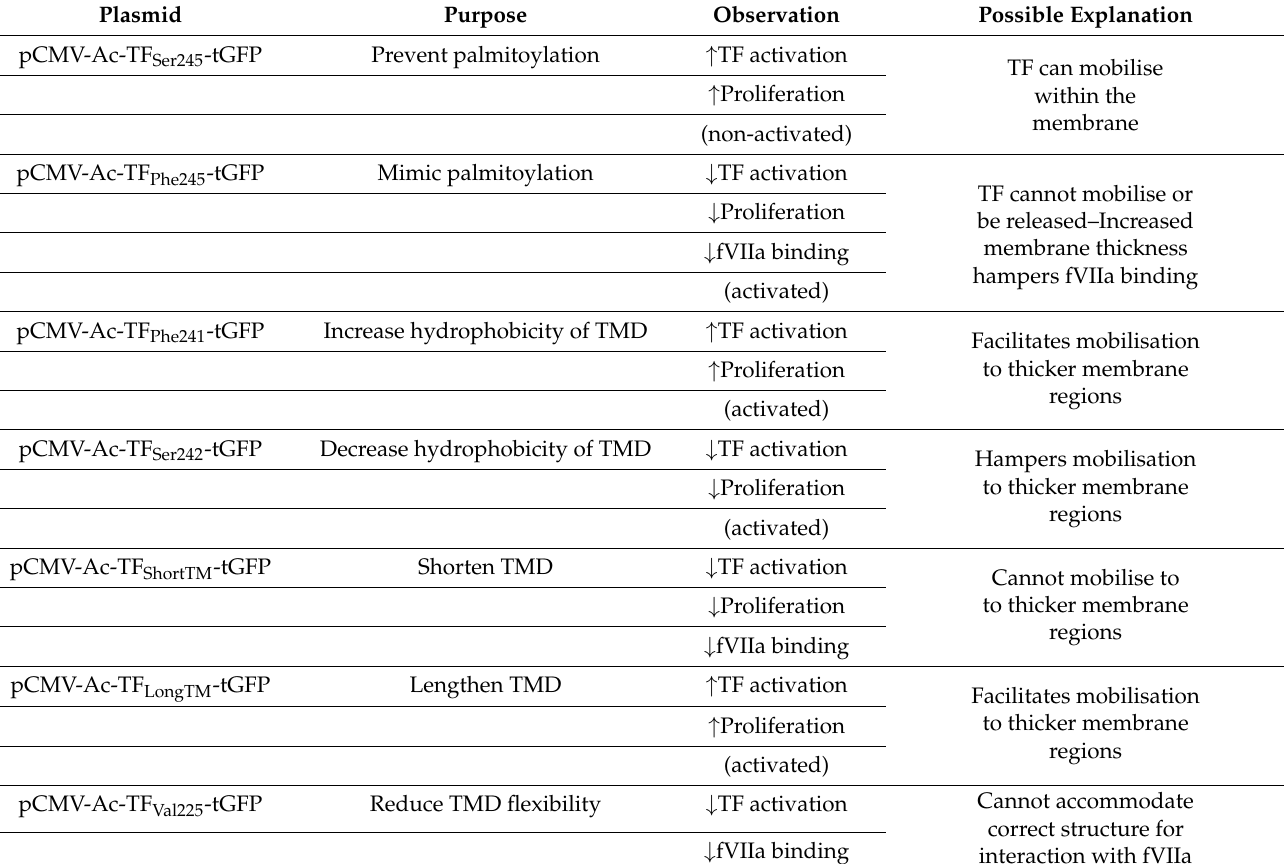
Table 4. Summary of the purpose of TF modifications and the main